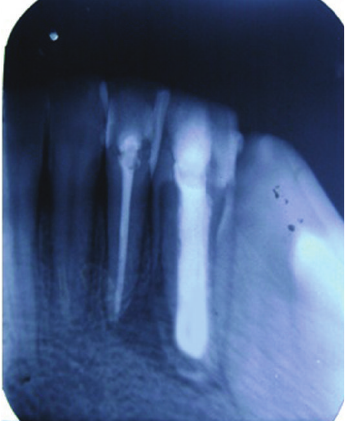
Figure 6: Radiograph reveals working length determination of 31 and 32.